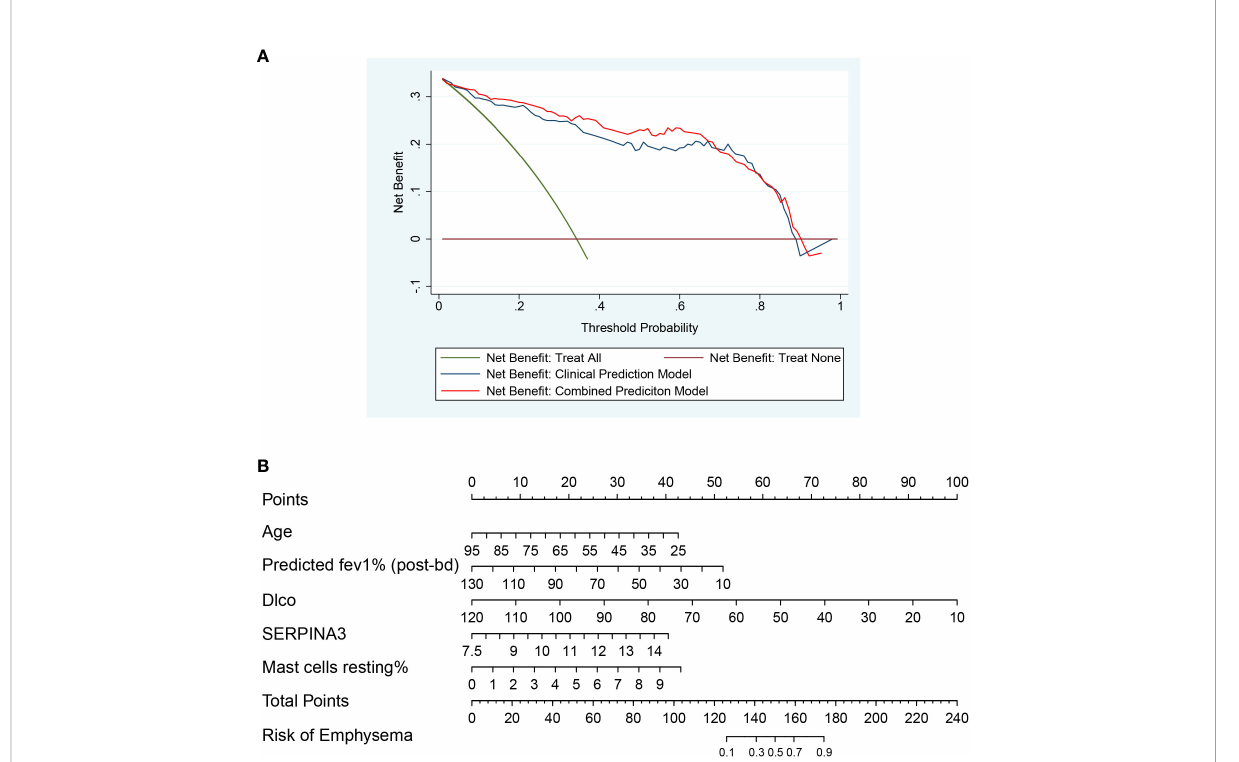
FIGURE 12 The DCA plot and nomogram. (A) The DCA plot of two prediction models, which shows that the combined prediction model has a wider threshold probability and higher net bene fi t than the clinical prediction model; (B) The nomogram of the combined prediction